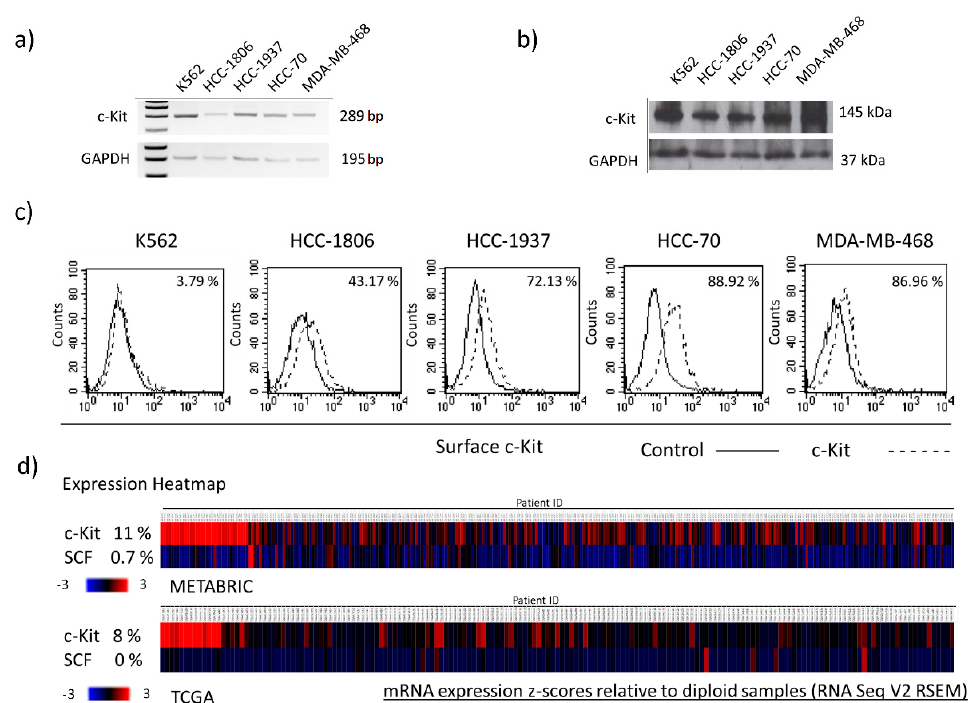
Figure 1. Expression of c-Kit in TNBC cell lines and tumors. The expression of c-Kit was evaluated in HCC-1806, HCC-1937, HCC-70, and MDA-MB-468 TNBC-derived cell lines by ( a ) RT-PCR, and ( b ) Western blot; ( c ) the presence of c-Kit at the cell membrane was evaluated by flow cytometry, the proportion of cells showing surface c-Kit is indicated. K562 cells were included as a c-Kit-expression positive control, and the expression of GAPDH was used as internal control for RT-PCR and Western blot assays. ( d ) The expression of c-Kit and its ligand SCF was investigated in tumor samples using transcriptomic data from the METABRIC (N = 299 samples), and TCGA (N = 168 samples) datasets. Gene overexpression was considered for samples showing a z-score relative to diploid samples > 2 (EXP > 2). Gene underexpression was considered when the z-score relative to diploid samples was < 2 (EXP < 2).